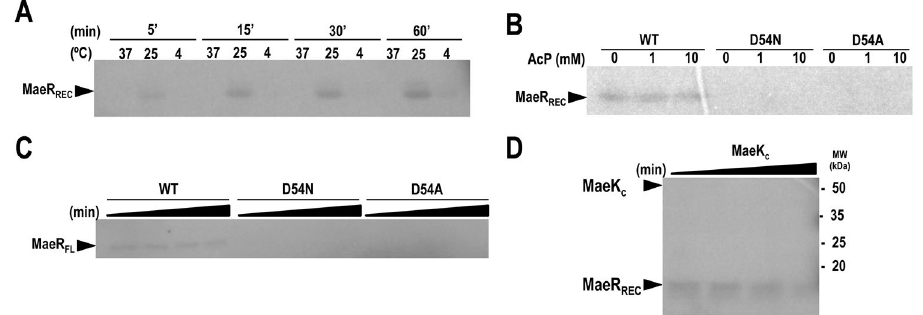
Figure 3. MaeR phosphorylation by acetylP and dephosphoarylation by MaeK. ( A ) Phosphorylation of the REC domain of MaeR in the presence of the radiolabeled phosphodonor acetylP and different temperatures (5, 25 and 37 °C) during different incubation times (5, 15, 30 and 60 min). ( B ) Phoshorylation of the MaeR REC domain for wild-type and mutant forms D54A and D54N with radiolabeled acetylP at room temperature for 1 h in the presence of 1 and 10 mM of cold acetylP. ( C ) Phosphorylation of MaeR full-length protein wild-type and mutant forms with radiolabeled acetylP at different incubation times (5, 10, 20 and 40 min). ( D ) Incubation of phosphorylated REC domain of MaeR in the presence of radiolabeled acetylP for 1 h and subsequent incubation with MaeK C during 1, 2.5, 5 and 15 min. Full-length autoradiographies are shown in Supplementary Fig.